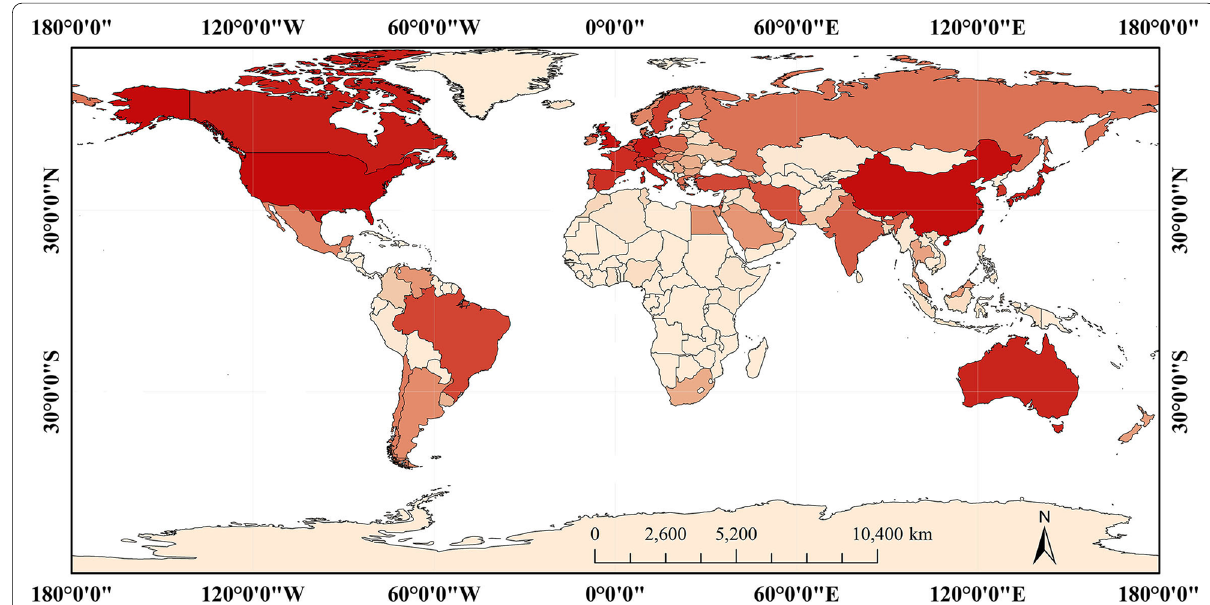
Fig. 4 Geographical distributions of publications. Countries in a darker color indicate a higher ranking in the number of publications and vice versa. This schematic shows that the leading countries are the USA, P. R. China, and Germany